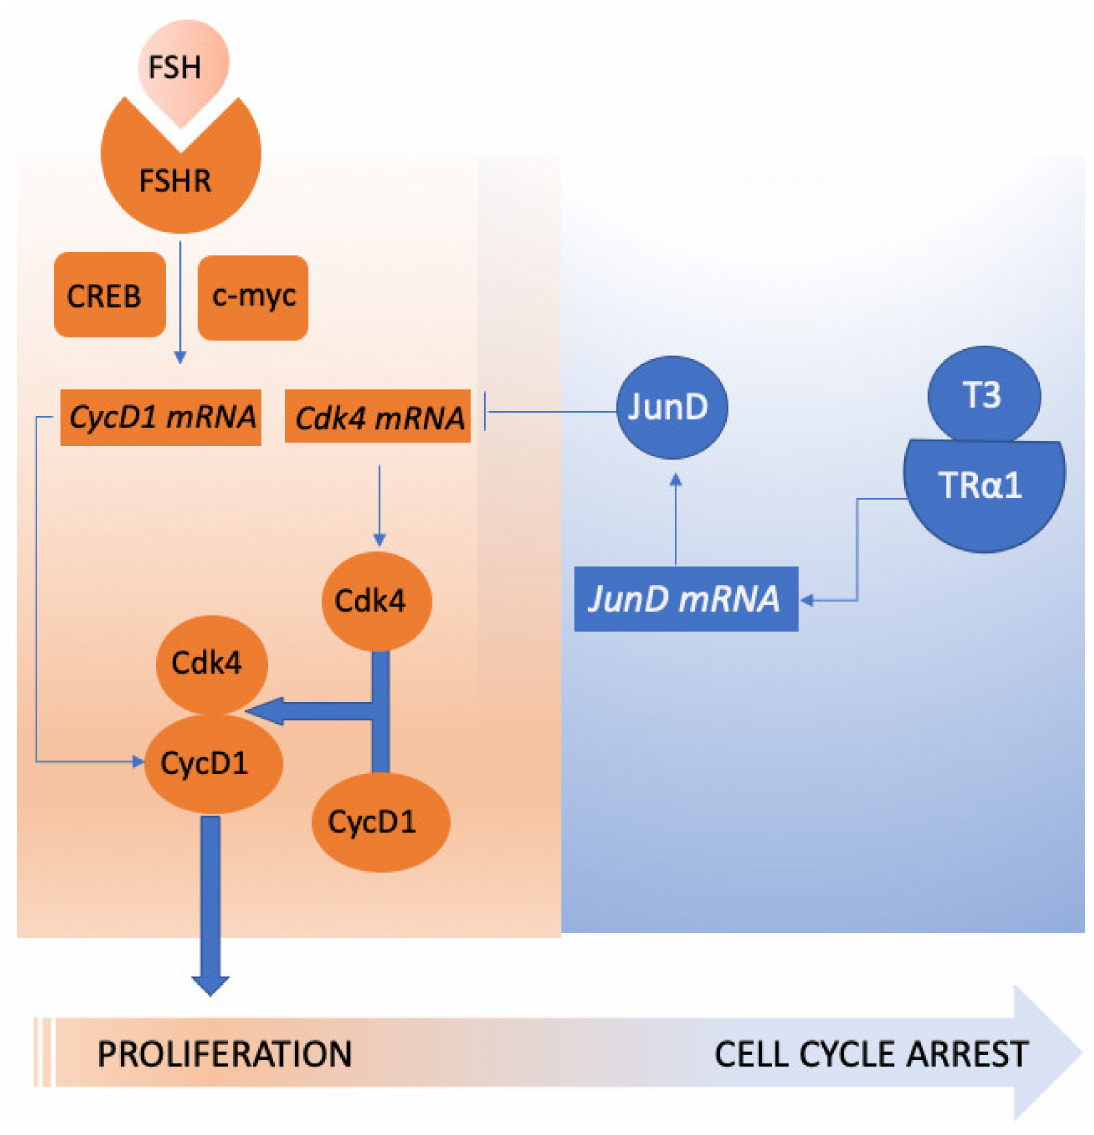
Figure 3. Triiodothyronine (T3) counteracts the mitotic response to FSH, by inhibiting the transcription of Cdk4, via the JunD transcriptional regulator. Thus, the association of Cdk4 to FSH-induced CycD1 is hampered, and Sertoli cell mitoses